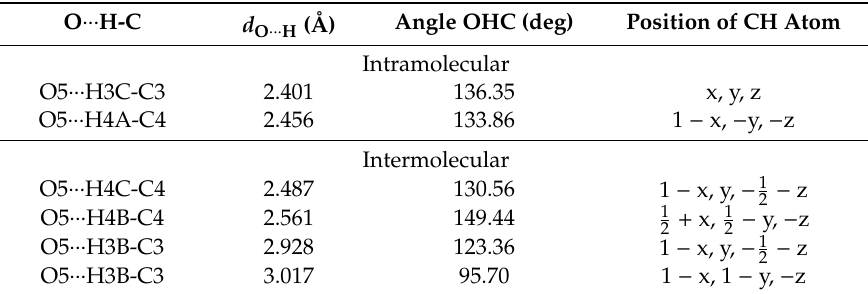
Table 3. Short ( < 3.1 Å) non-equivalent O ··· H contacts a of atom O5 in SQ.